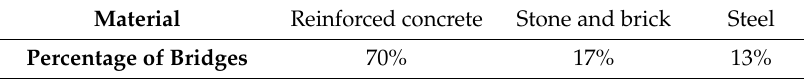
Table 9. Bridge distribution by material in the ÖBB bridge stock in 2016 [46].